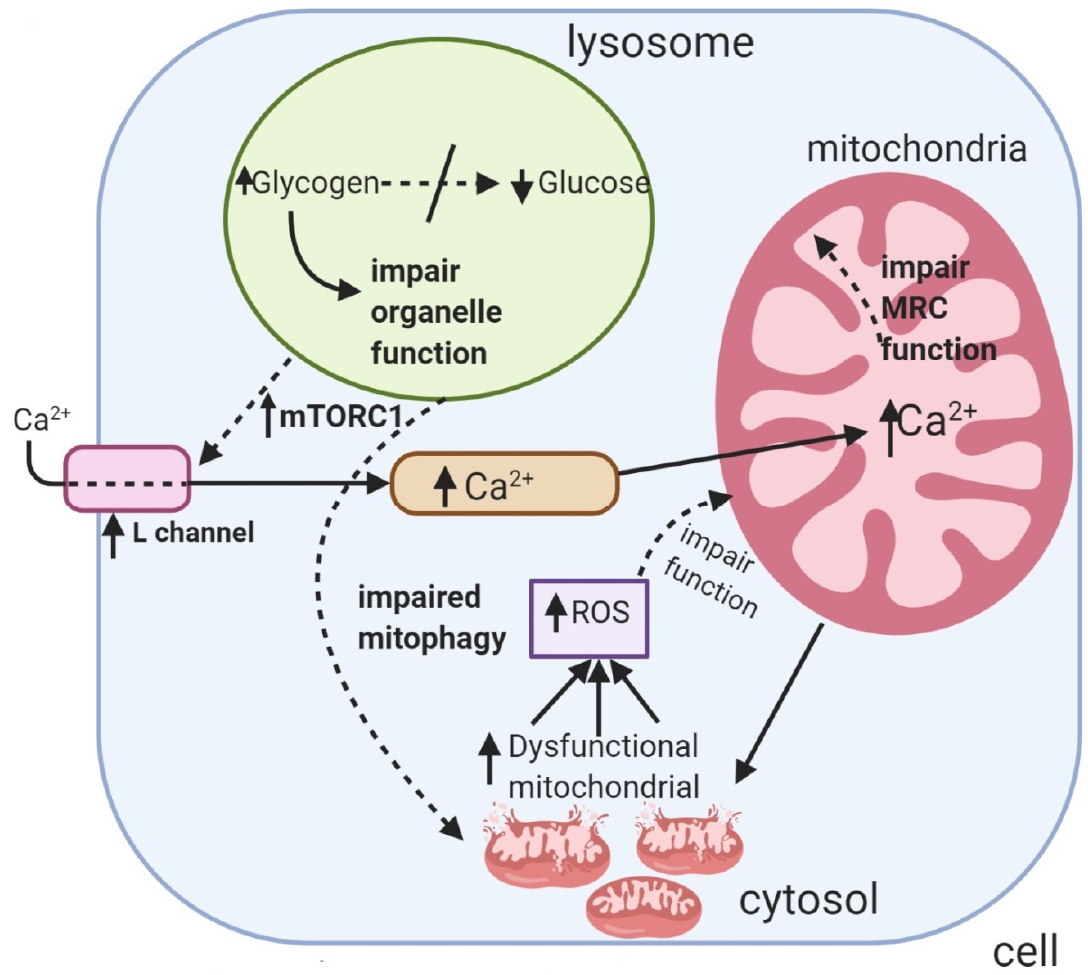
Figure 2. The putative mechanisms that have been implicated in inducing mitochondrial dysfunction in Pompe disease. MRC: Mitochondrial respiratory chain. Ca2+: Calcium. MTORC1: mammalian target of rapamycin complex 1. ROS: Reactive oxygen species.